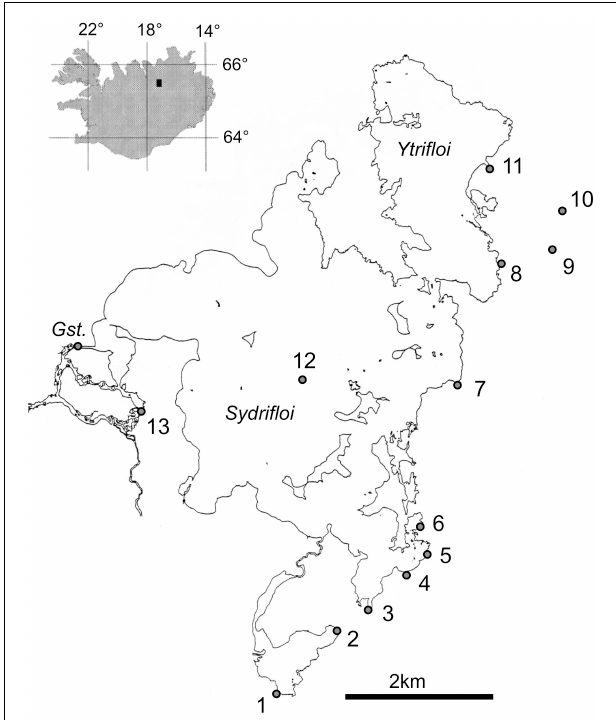
Table 1 . The monitoring for 2000–2001 was made at the outlet Geirastadaskudur (Gst.).